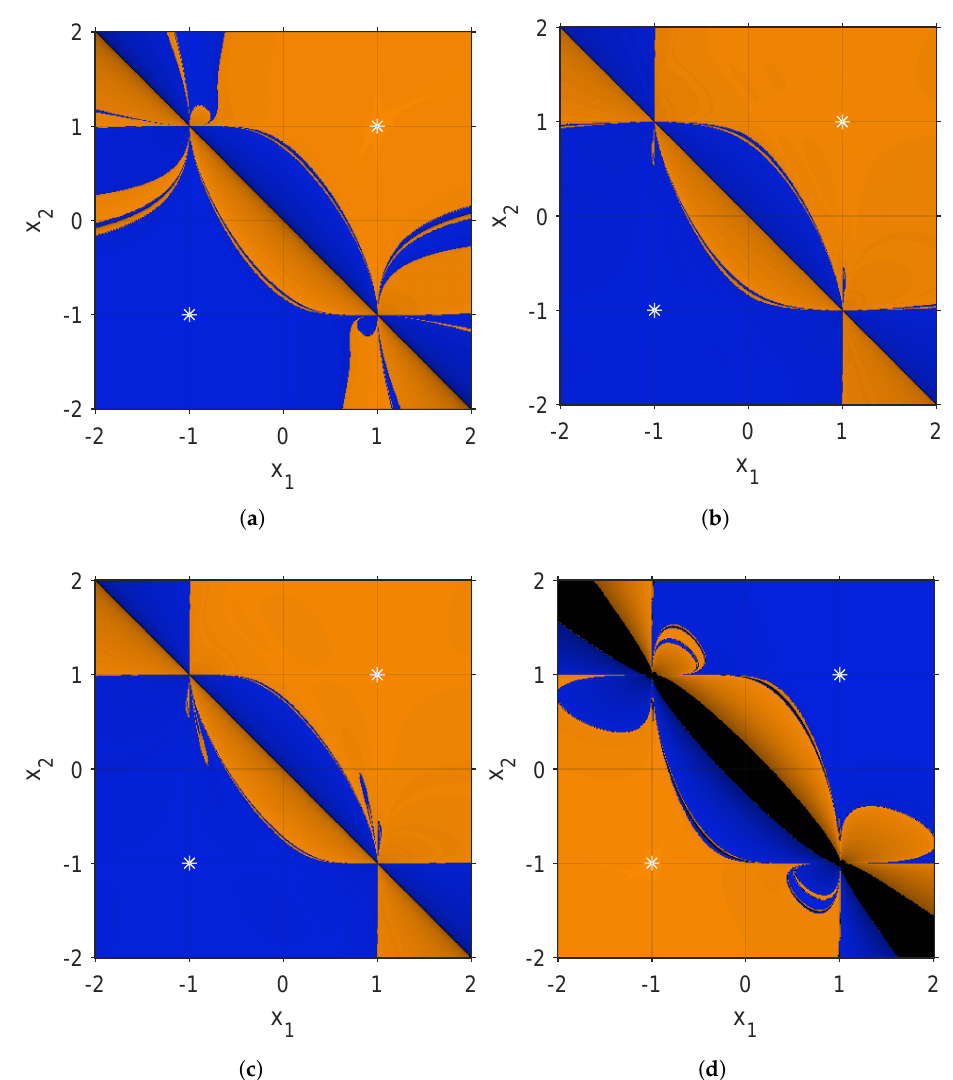
Figure 6. Dynamical planes of solving system (21) with the methods ( a ) AC, ( b ) FS1, ( c ) FS2, and ( d )